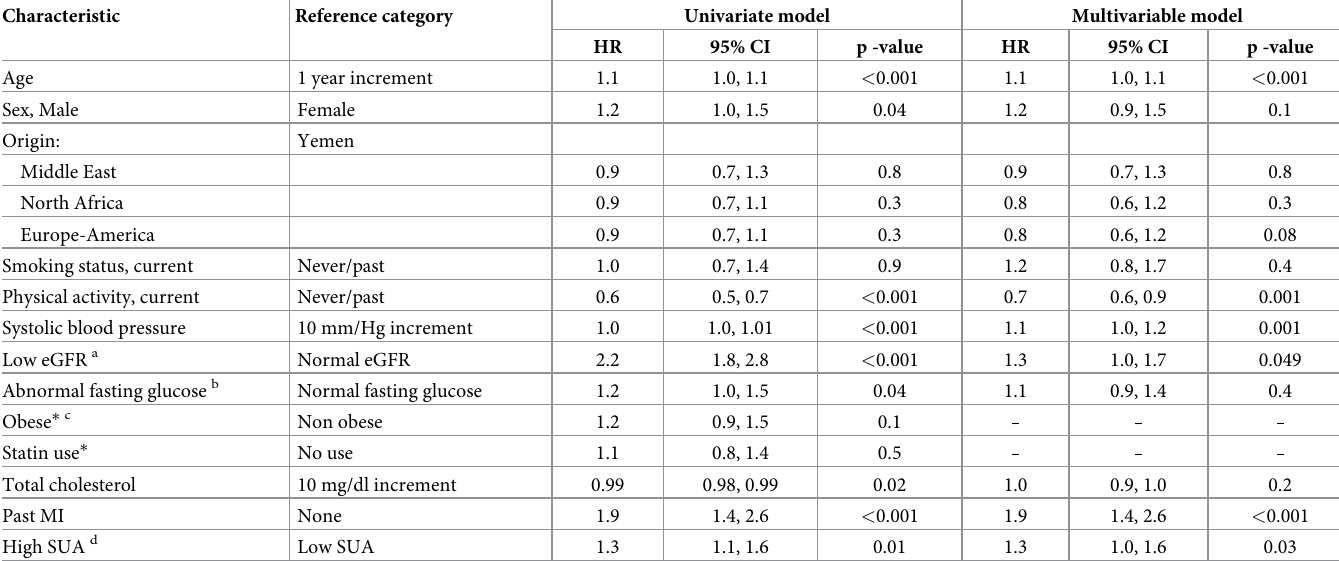
Table 3. Cox regression models for associations between SUA and all-cause mortality.